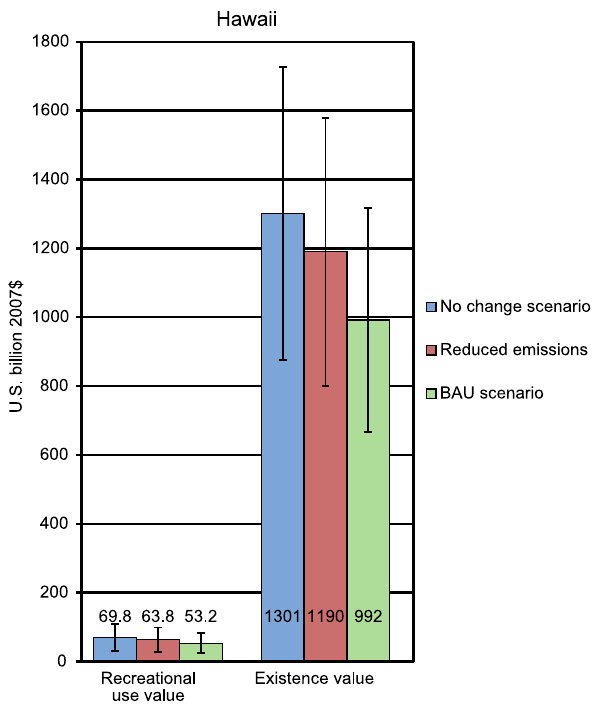
Figure 4. Economic values (with 95% confidence interval) for BAU and reduced emission scenarios for Hawaii.